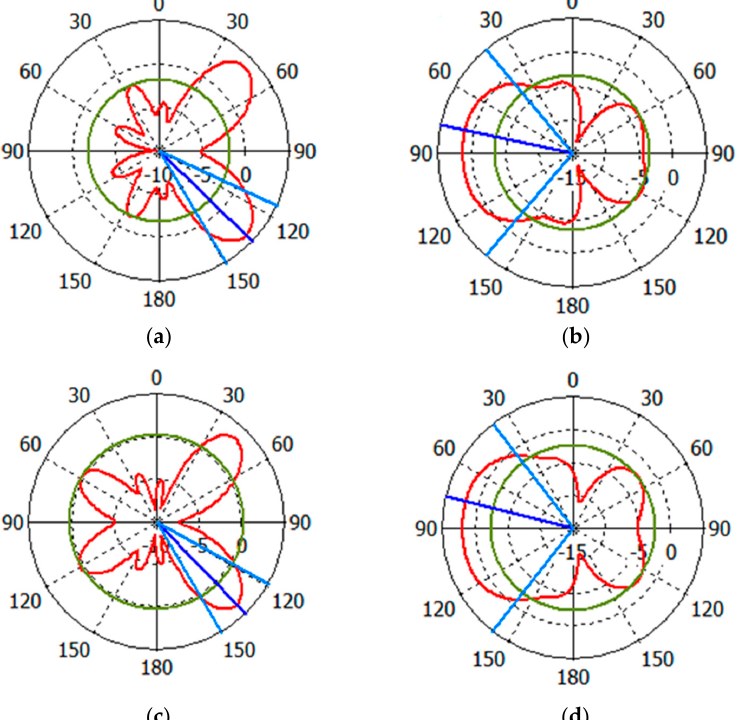
Figure 11. The radiation pattern of the proposed antennas ( a ), E plane of antenna A ( b ), H plane of antenna A ( c ), E plane of antenna B ( d ) and H plane of antenna B.